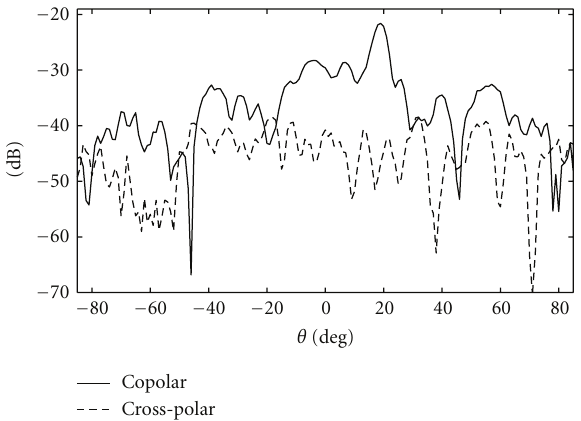
Figure 10: Measured radiation pattern (copolar and cross-polar components on x-z plane) for a main beam θ mb = 20 ◦ .